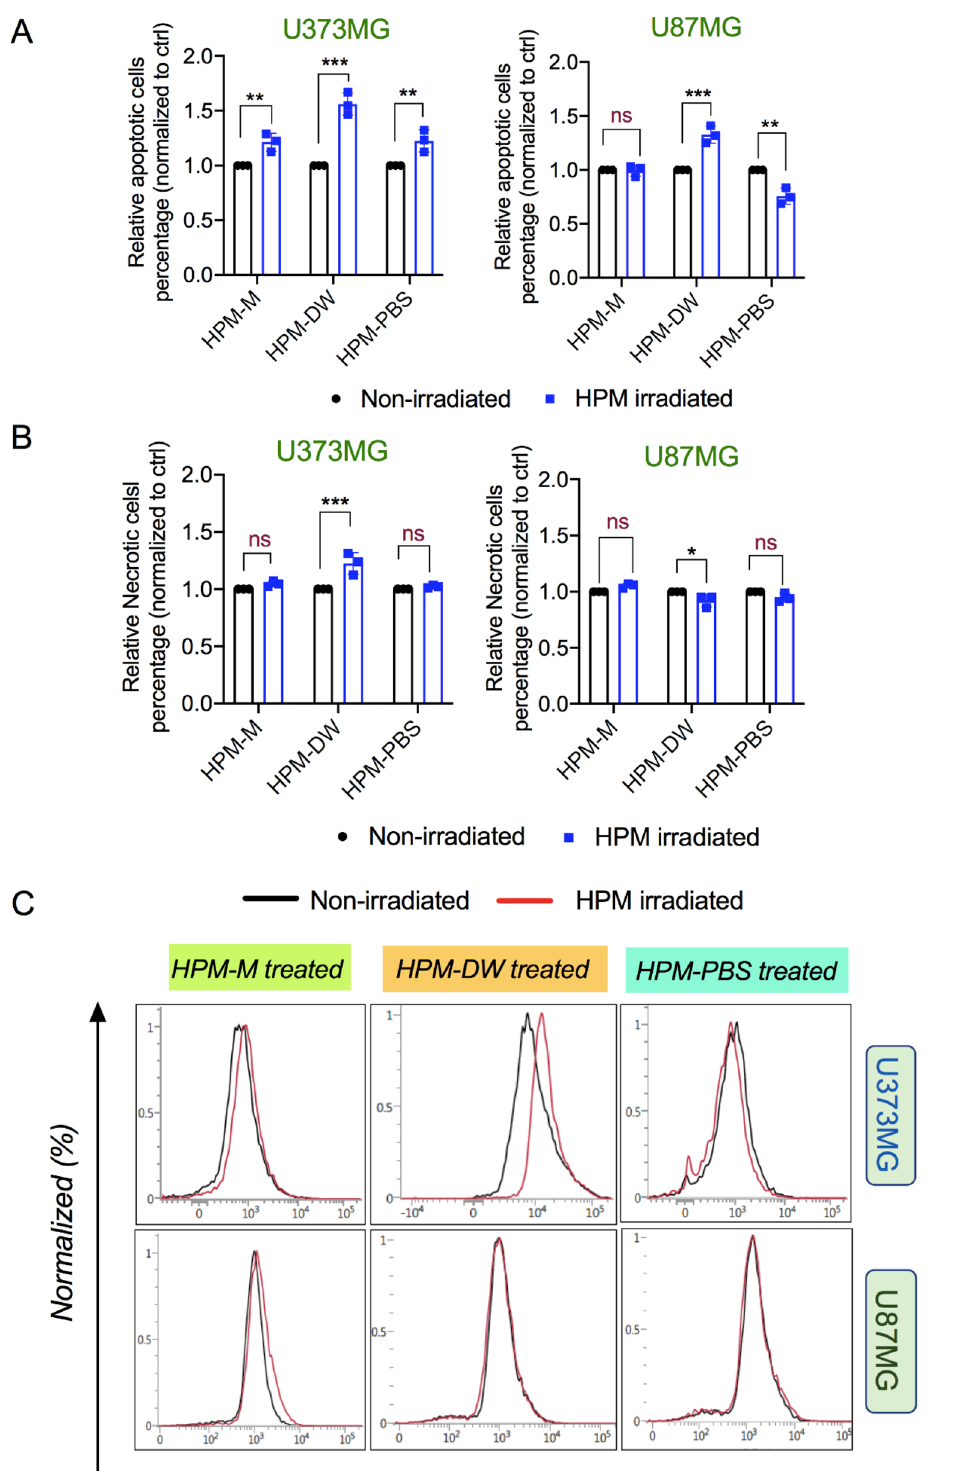
Figure 6. Effect of high power microwave-irradiated solutions on the mitochondrial membrane and apoptosis/ necrosis. ( A ) Representative graph showing the results of an apoptosis assay in U373MG (Left) and U87MG (Right) cells with high power microwave (HPM)-irradiated media, DW, and PBS as the treatment groups (left to right respectively) ( B ) A graph indicating necrotic cell populations in U373MG (Left) and U87MG (Right) cells with the indicated treatment groups. ( C ) Representative FACS histogram plots showing the Mitoflow reagent fluorescence in U373MG (upper side) and U87MG cells (lower side) in groups treated with HPM-irradiated Media, DW, and PBS, respectively (from left to right). Non-significance is signified as ns. * p < 0.05, ** p < 0.01, *** p <